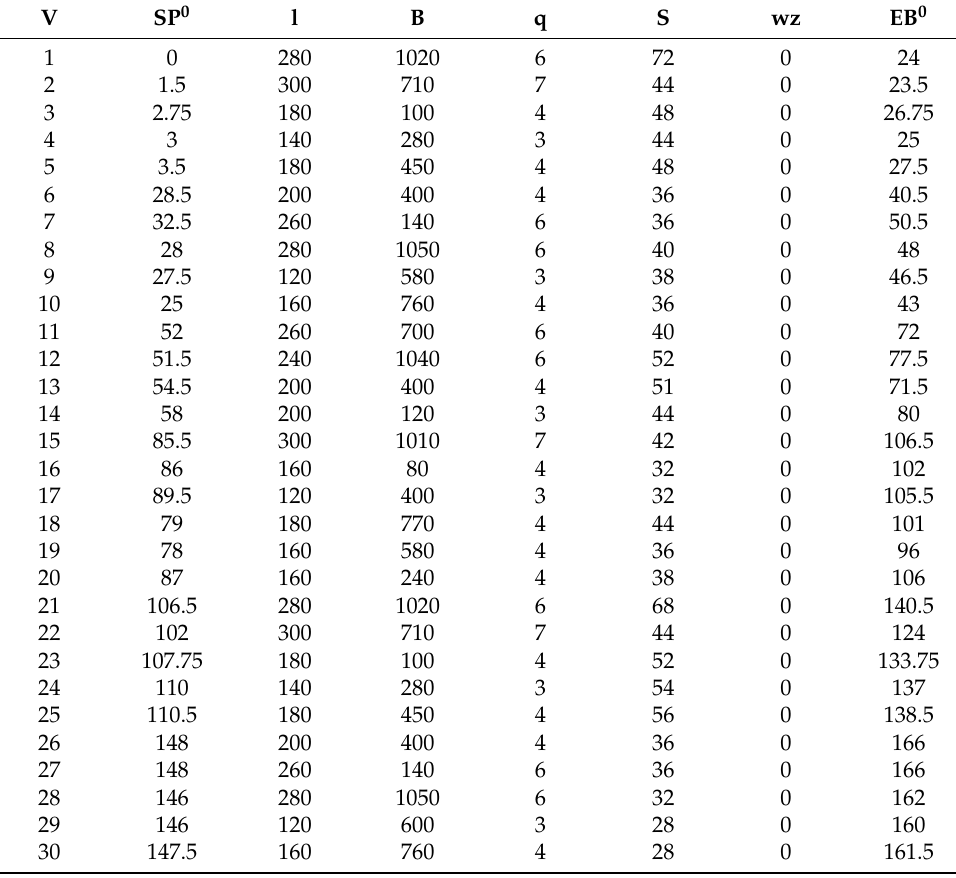
Table 1. Information of originally scheduled arrival vessels.